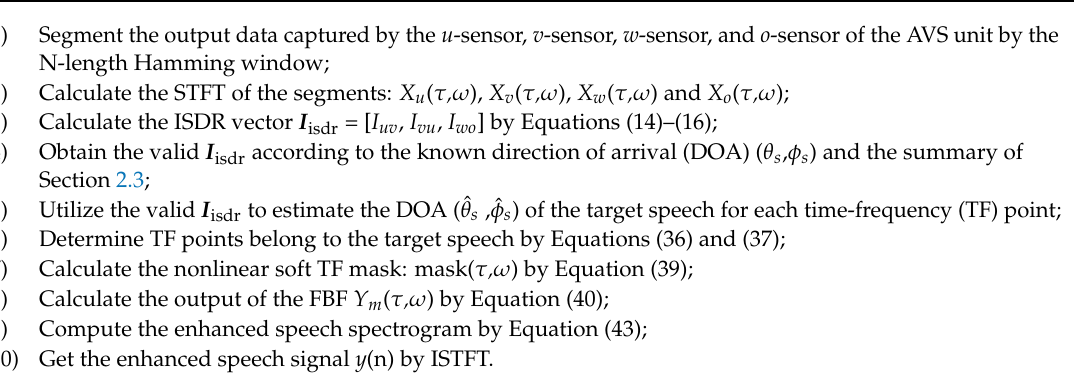
Table 2. The pseudo-code of our proposed AVS-SMASK